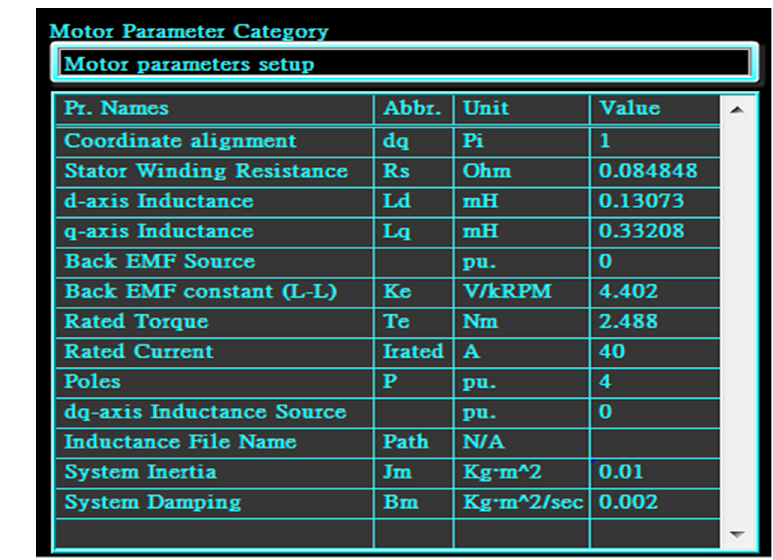
Figure 6. Block diagram of the fuzzy controlled system.